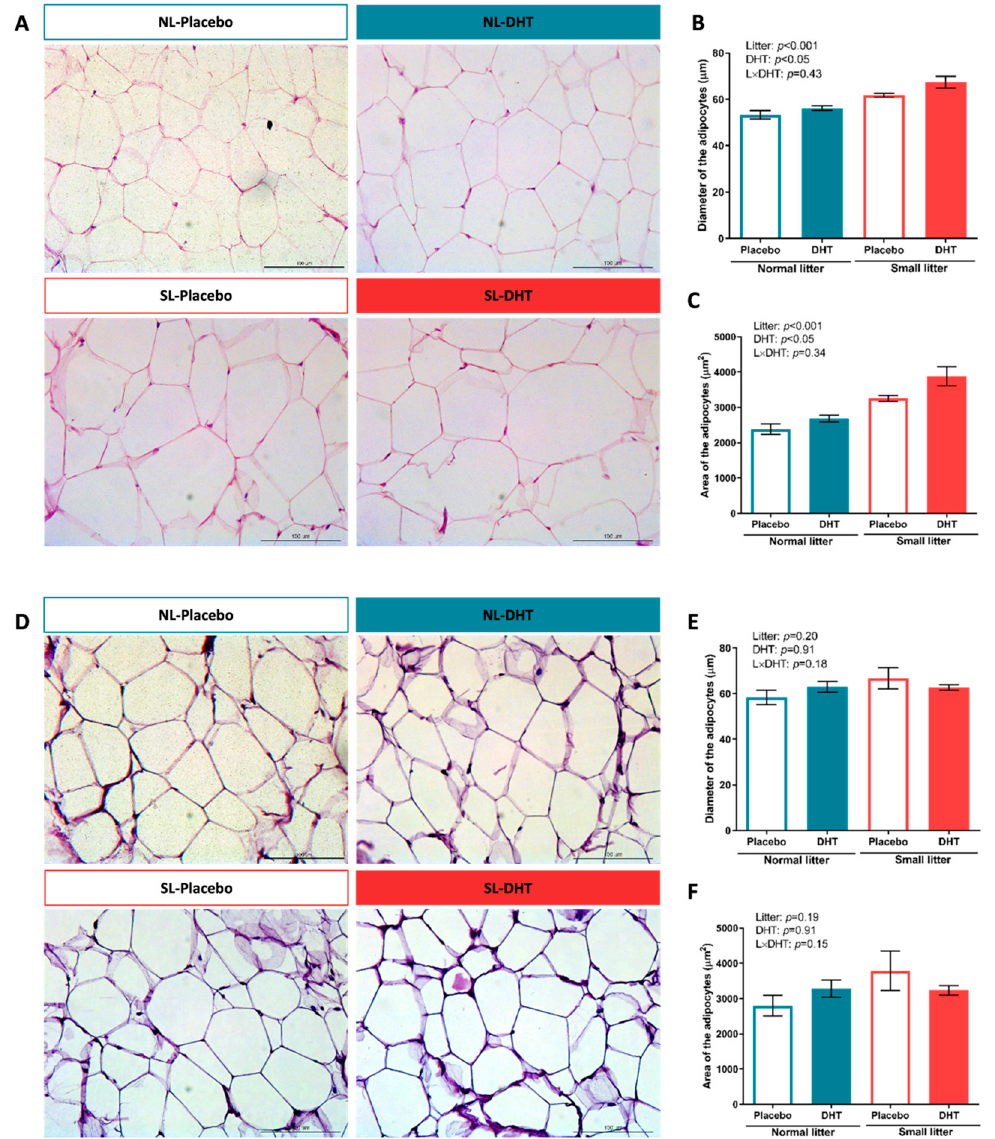
Figure 2. Histological and morphometric analysis of VAT and SAT of placebo and DHT treated rats from small litters (SL) and normal litters (NL). Representative micrographs of hematoxylin-eosin stained sections of ( A ) VAT and ( D ) SAT (bar = 100µm), and morphometric analysis of ( B , E ) cell diameter and ( C , F ) cell area in the VAT and SAT, respectively. Data are shown as mean ± SEM ( n = 6 animals per group). To determine the effects of litter size reduction and DHT treatment, as well as their interaction, a two-way ANOVA was performed, and the difference was considered significant at p < 0.05.